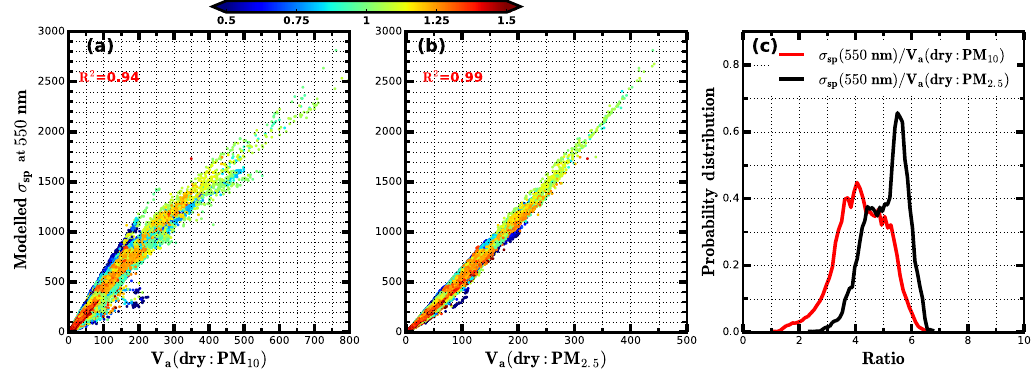
Figure 3. (a, b) Modelled σ sp at 550nm based on PNSD and BC vs. V a (dry) of PM 10 or PM 2 . 5 calculated from measured PNSD. PNSD and BC datasets from six field campaigns listed in Table 1 are used. The unit of V a (dry) is µm 3 cm − 3 and the unit of σ sp is Mm − 1 . Colours of scattered points in panels (a) and (b) represent corresponding values of the Ångström exponent. R 2 is the square of correlation coefficient. Panel (c) represents the probability distribution of the modelled ratio between σ sp at 550nm and V a (dry) of PM 10 or PM 2 . 5 .